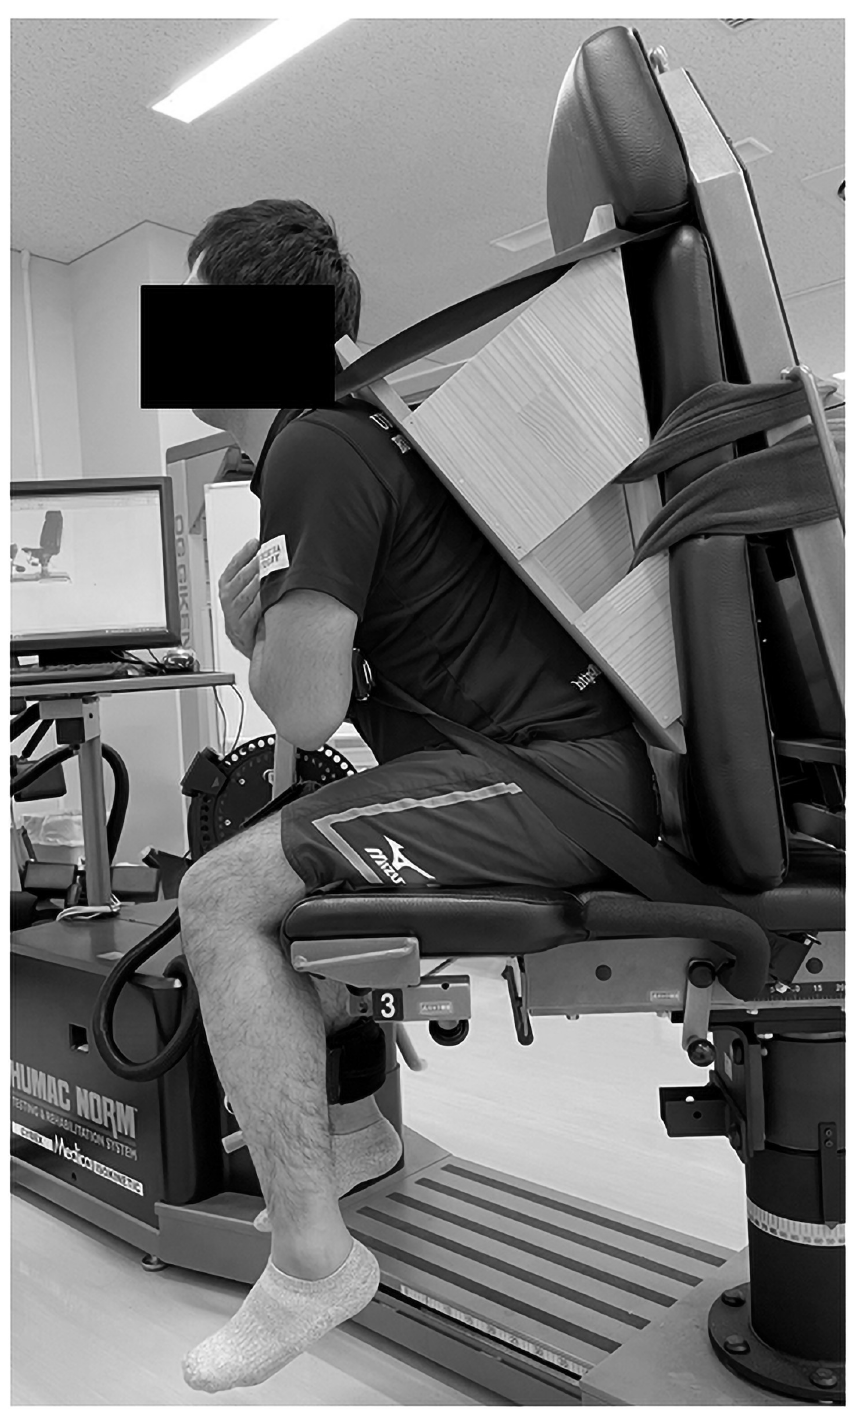
Fig 1. Experimental